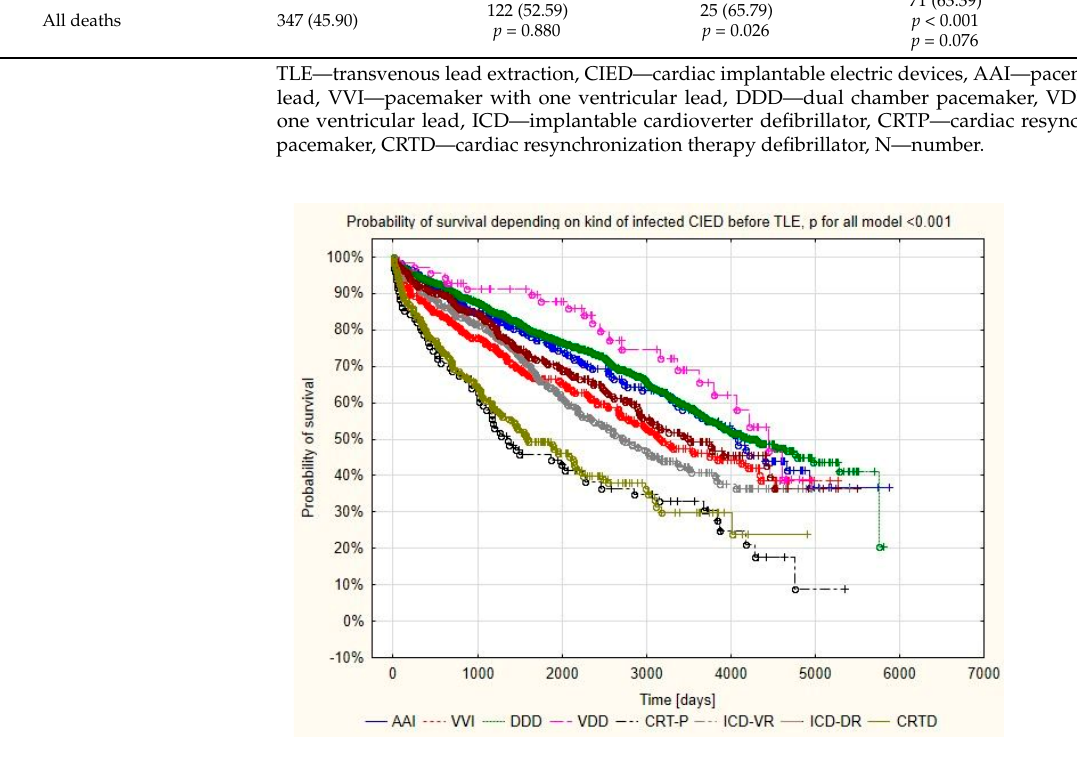
Figure 2. Kaplan–Meier survival curves of patients with the different types of infected CIED.